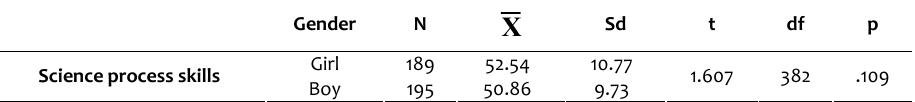
Table 13. Results of T-Test Analysis on Science Process Skills of the 5-Year-Old Preschoolers based on Gender